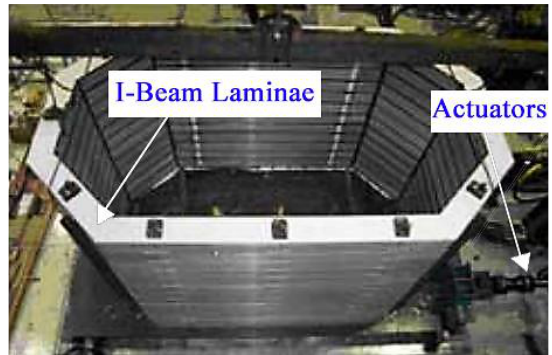
Figure 10. ( a ) Laminae ( b ) skeleton for laminae (From [20]; modified).